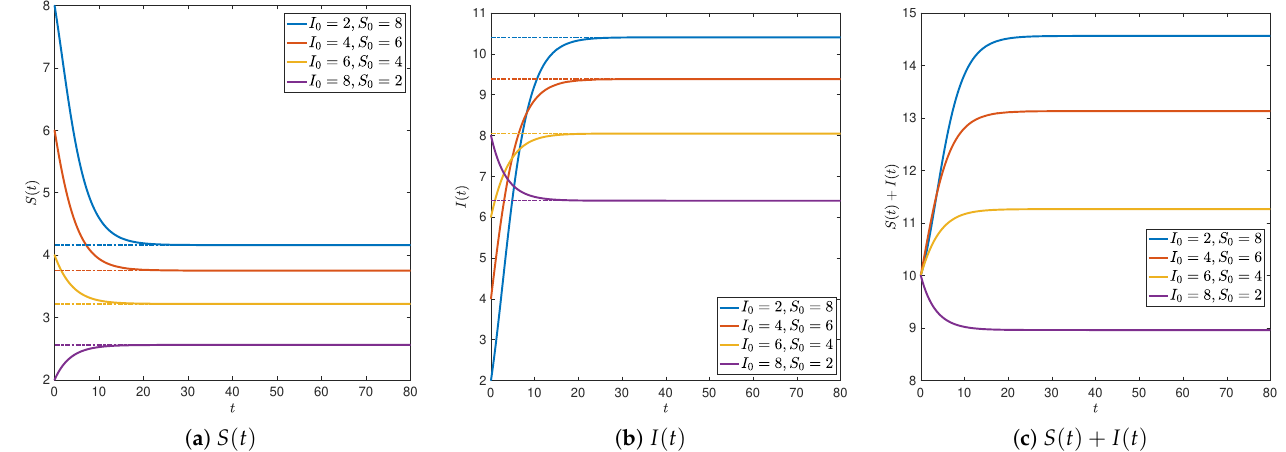
Figure 5. Numerical solutions to (2) for α = 0.5, β = 0.7, γ = 0.2 and M ( α ) ≡ 1 as I 0 and S 0 change.